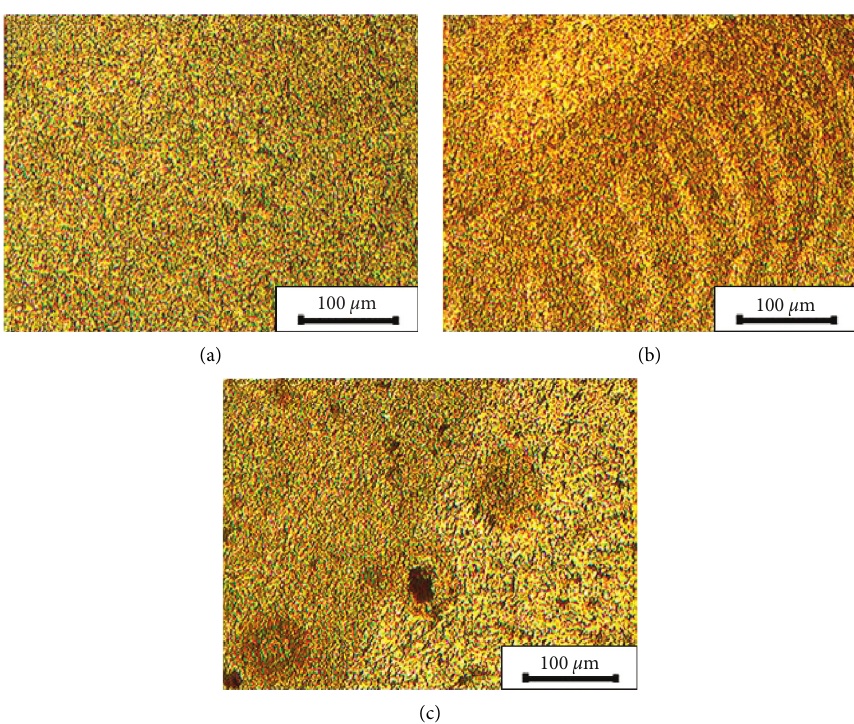
Figure 7: Photographic view of optical microstructures: (a) weld sample prepared with 2300rpm and 40mm/min, (b) weld sample prepared with 2300rpm and 60mm/min, and (c) weld sample fabricated with 1600rpm and